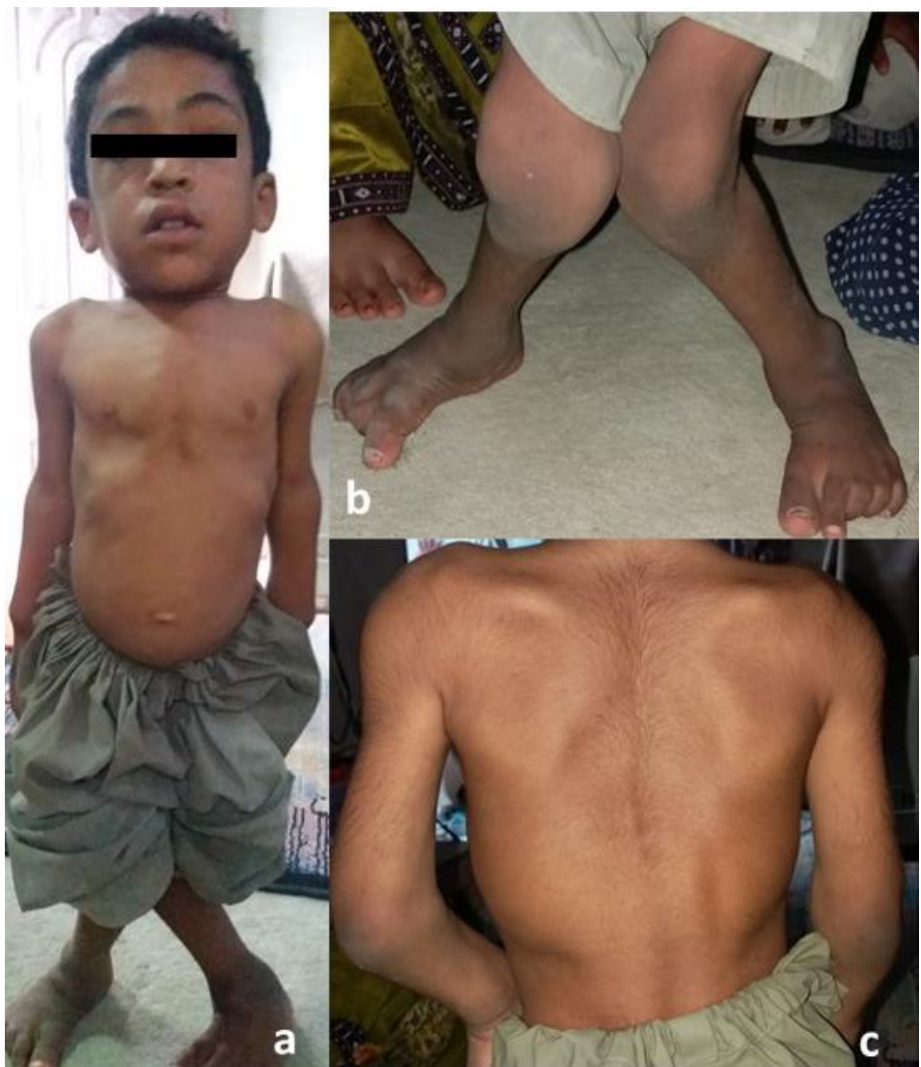
Figure 2. Morphological features of proband: ( a ) note the short stature, frontal bossing, flat nasal bridge, short neck, and protrusion of the chest.; ( b ) note the valgus knee deformity; and ( c ) curvature of spine/scoliosis.